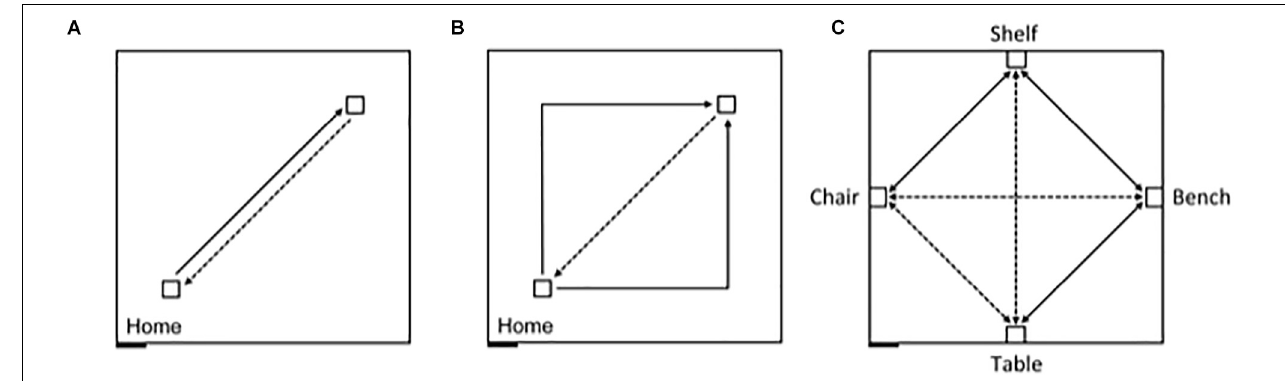
FIGURE 1 | Schematic representation of the experimental design, carried out in an 8 m × 8 m testing room. The black rectangle at the bottom left represents the entry door to the room. Solid lines indicate guided trajectories; dashed lines indicate direct paths that participants were verbally requested to make. (A) Egocentric task, straight paths: 7 m straight line guided trajectory, 7 m return path. (B) Egocentric task, angled paths: 10 m angular guided trajectory with a right or left turn (5 m + 5 m), and 7 m return path. (C) Allocentric task: guided routes (solid) and novel routes (dashed) between four objects, in absence of vision. The paths between the bench and the chair, and between the table and the shelf were 7 m long; the other paths were 5 m long.